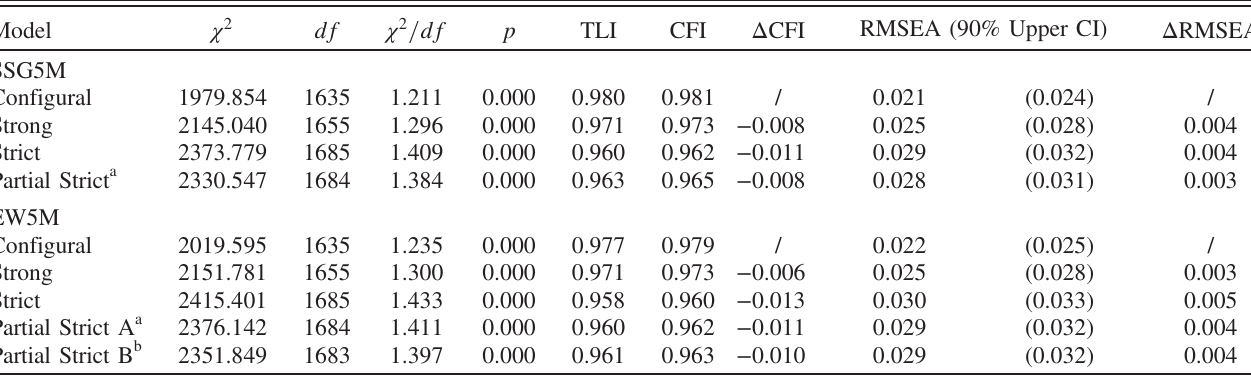
TABLE V. Model fit statistics of the SSG5M and EW5M models of the FCI for longitudinal measurement invariance restrictions.